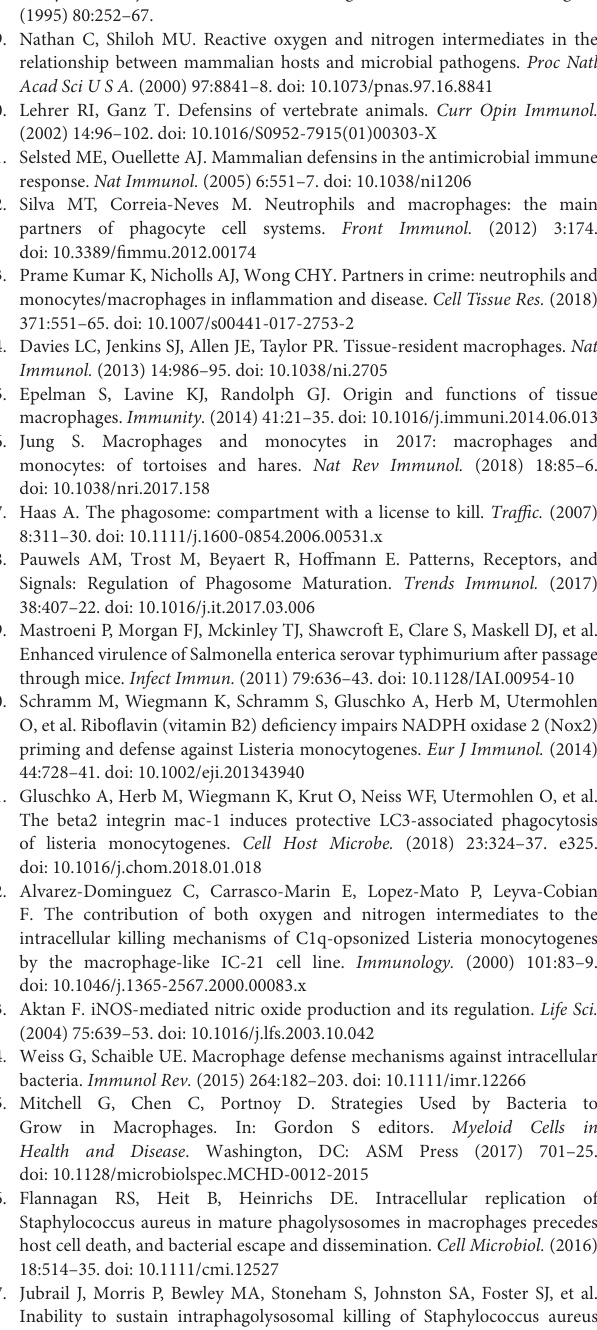
Supplementary Figure 1 | Flow cytometry analysis of S. aureus clearing in BMDMs. BMDMs were infected with GFP-expressing S. aureus MW2 opsonized with 5% NMS and assessed for clearing by flow cytometry. (A) representative dot-plot to demonstrate gating strategy of BMDM population. 5000 events within gate R1 were measured and the percentage of GFP positive BMDMs within this gate was assessed by histogram plot analysis of counts versus channel FL1-H (GFP fluorescence). (B) representative histograms of wildtype (left) or NOX2-/- BMDMs infected with MOI 1.5, MOI15 and MOI30 to define conditions for optimal loading and clearing assays. M1, this marker represents the gate for GFP positive